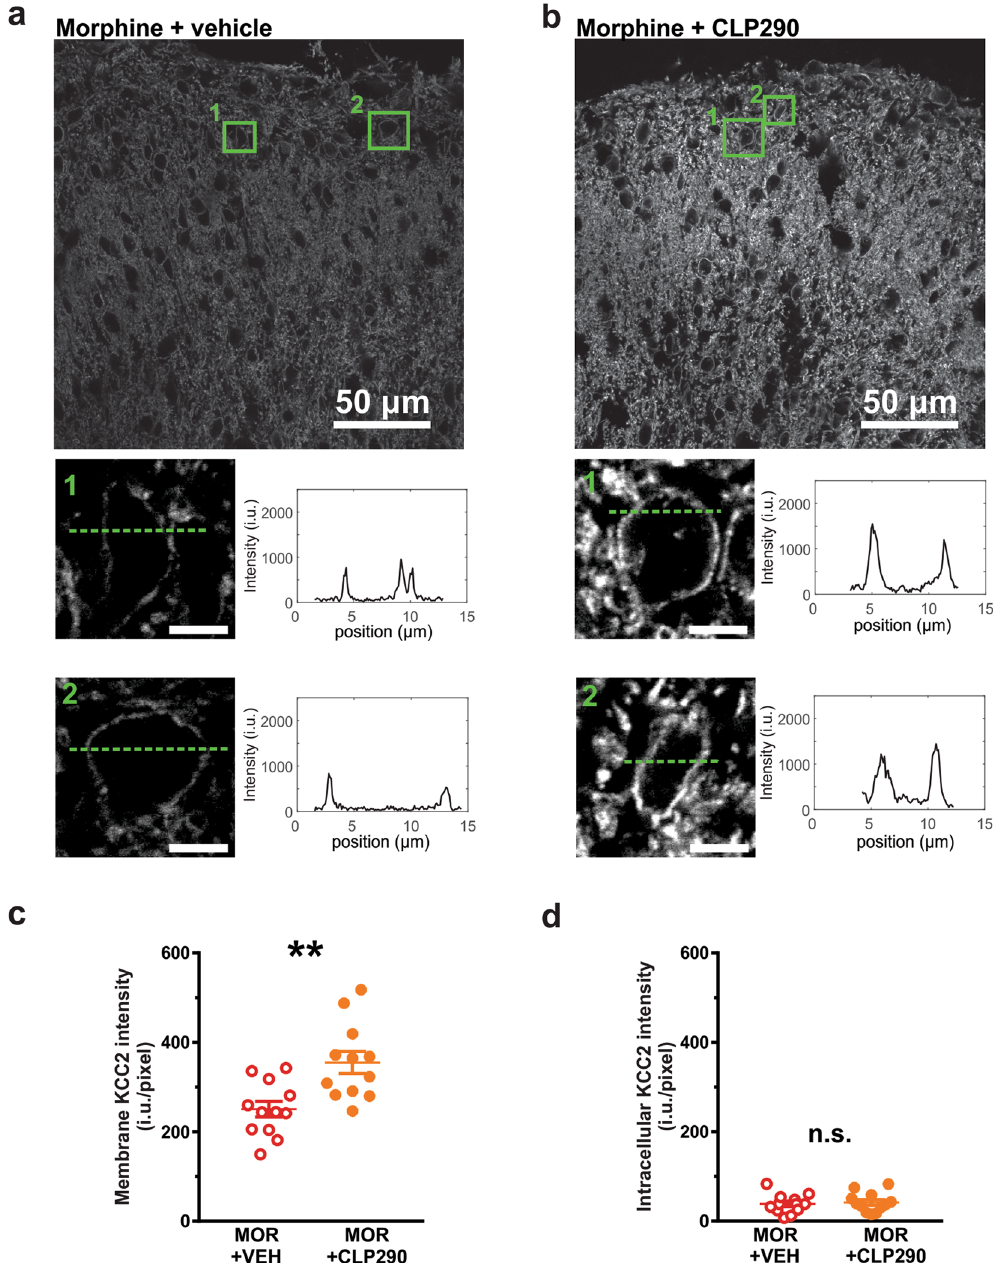
Figure 2. Effect of repeated morphine and CLP290 co-treatment on KCC2 expression. ( a , b ) KCC2 expression in the SDH of MOR + VEH and MOR + CLP290 treated rats. The enlargements below show the main membrane localization of KCC2 staining in representative cell bodies of the SDH. ( c , d ) Expression of membrane KCC2 (intensity per pixel) was significantly higher in MOR + CLP290 rats (n = 12) as compared to MOR + VEH rats (n = 12, t-test, ** P = 0.003). The difference in intensity per pixel was significant for the membrane compartment ( c ; t-test, ** P = 0.002) but not the intracellular compartment ( d , t-test, P = 0.4). Abbreviations: VEH = vehicle (20% HP β CD); MOR = morphine; SDH = superficial dorsal horn; n.s. = not